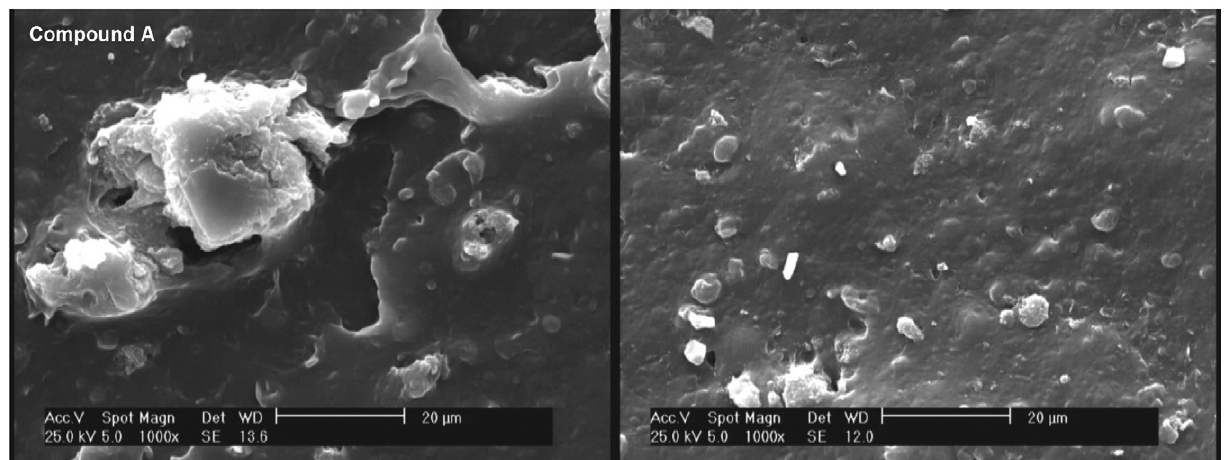
interaction, higher crosslink density and lower filler-filler